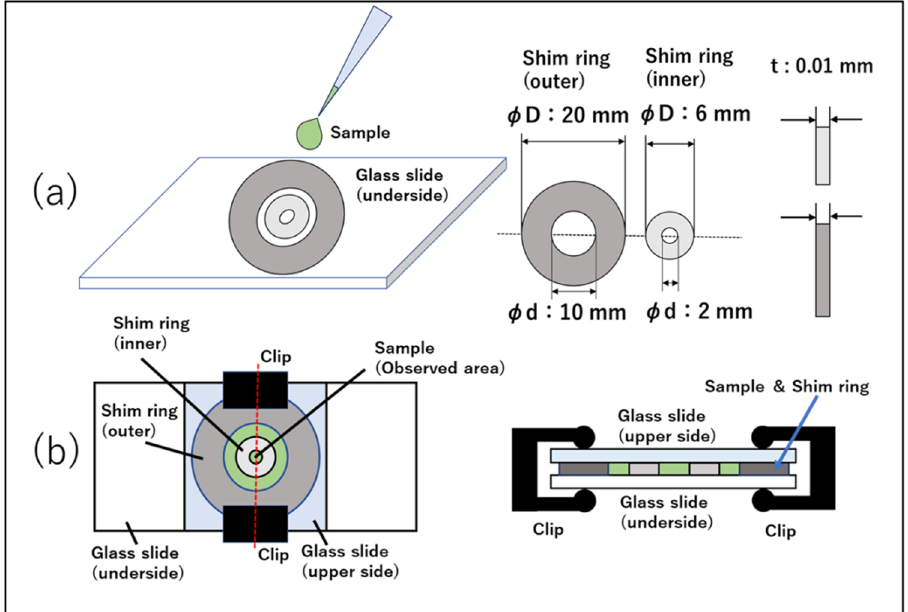
Figure 1. Method for fabricating quasi-2D microdevice. ( a , b ) Procedure for fabricating the device. Two rings of different sizes are used. Thickness tolerance is ± 0.003 mm for both rings. ( b ) Top view and cross section from the side of the completed device. A clip is placed directly above the outer ring, which serves as a spacer.